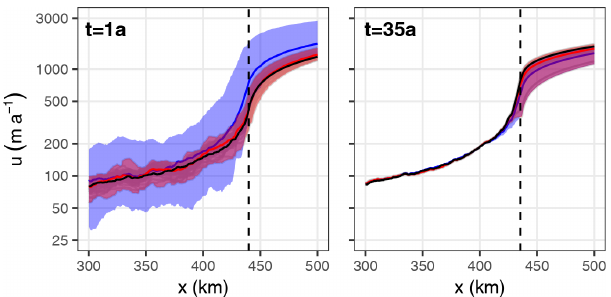
Figure 6. Velocity, u , at t = 1a and t = 35a. The reference is in black; the ensemble mean before and after the analysis is in blue and red, respectively. The shading shows the ensemble spread be- tween the minimum and maximum. The dashed vertical black line indicates grounding line